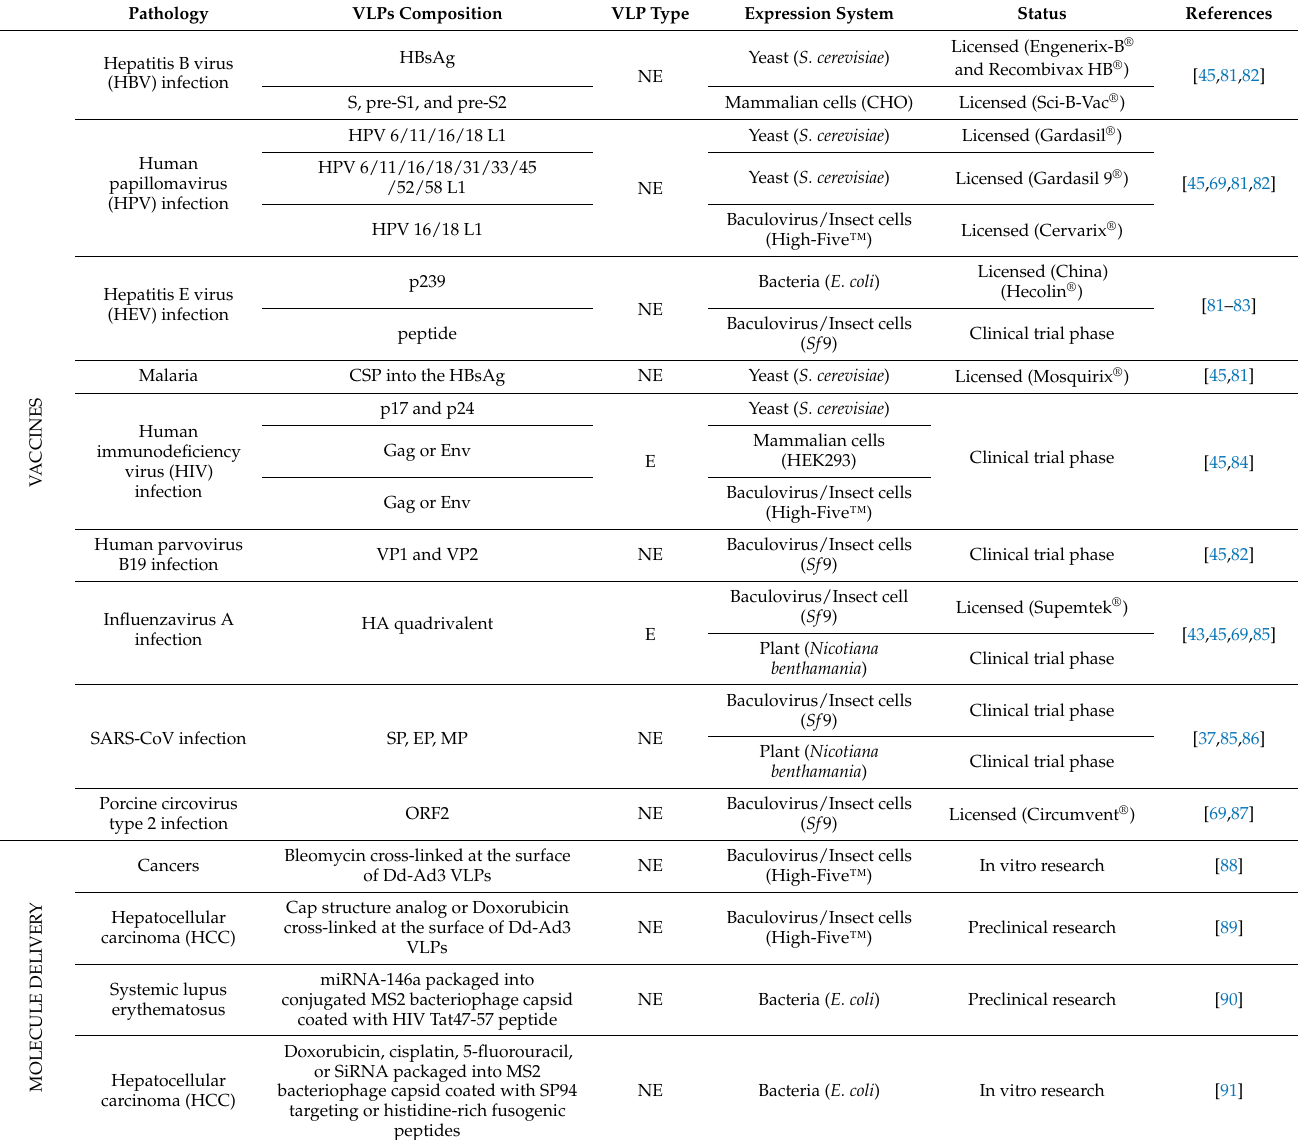
Table 2. Non-exhaustive applications of VLP in vaccines or molecule